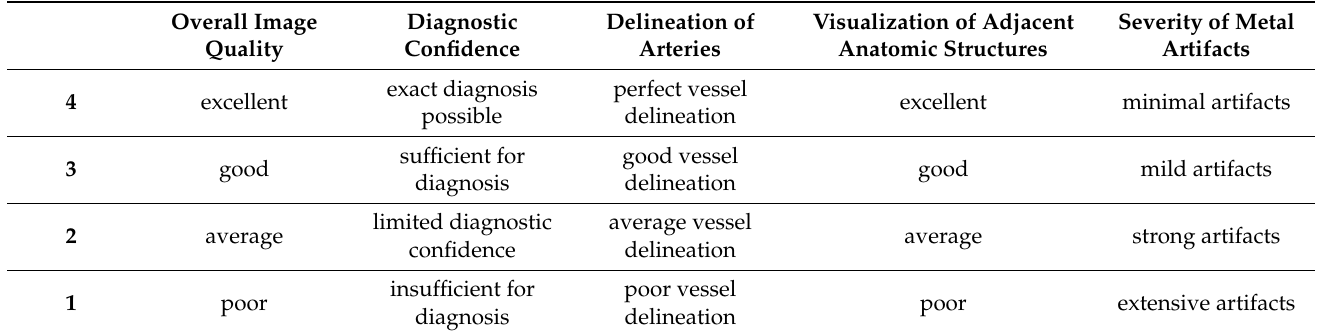
Table 1. Four-point Likert scale and the evaluated categories of the qualitative